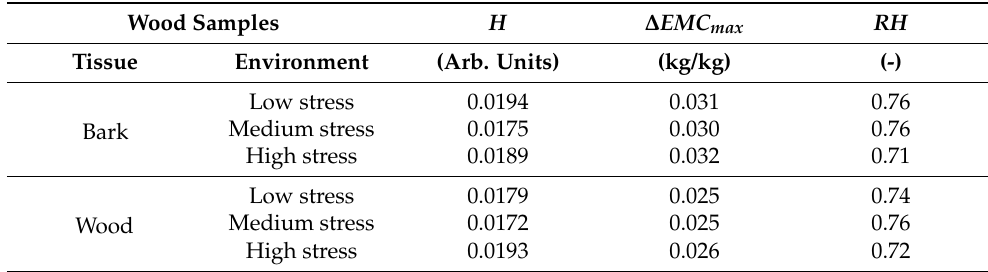
Figure 3. S orption hysteresis Δ EMC of lime ( Tilia cordata Mill.): ( a ) bark and ( b ) wood at 20 °C depending on growth conditions: A, B, C—low, medium and high environmental stress, respectively. Table 5. Sorption hysteresis loops ( H ), maximum differences in EMC for desorption and adsorption